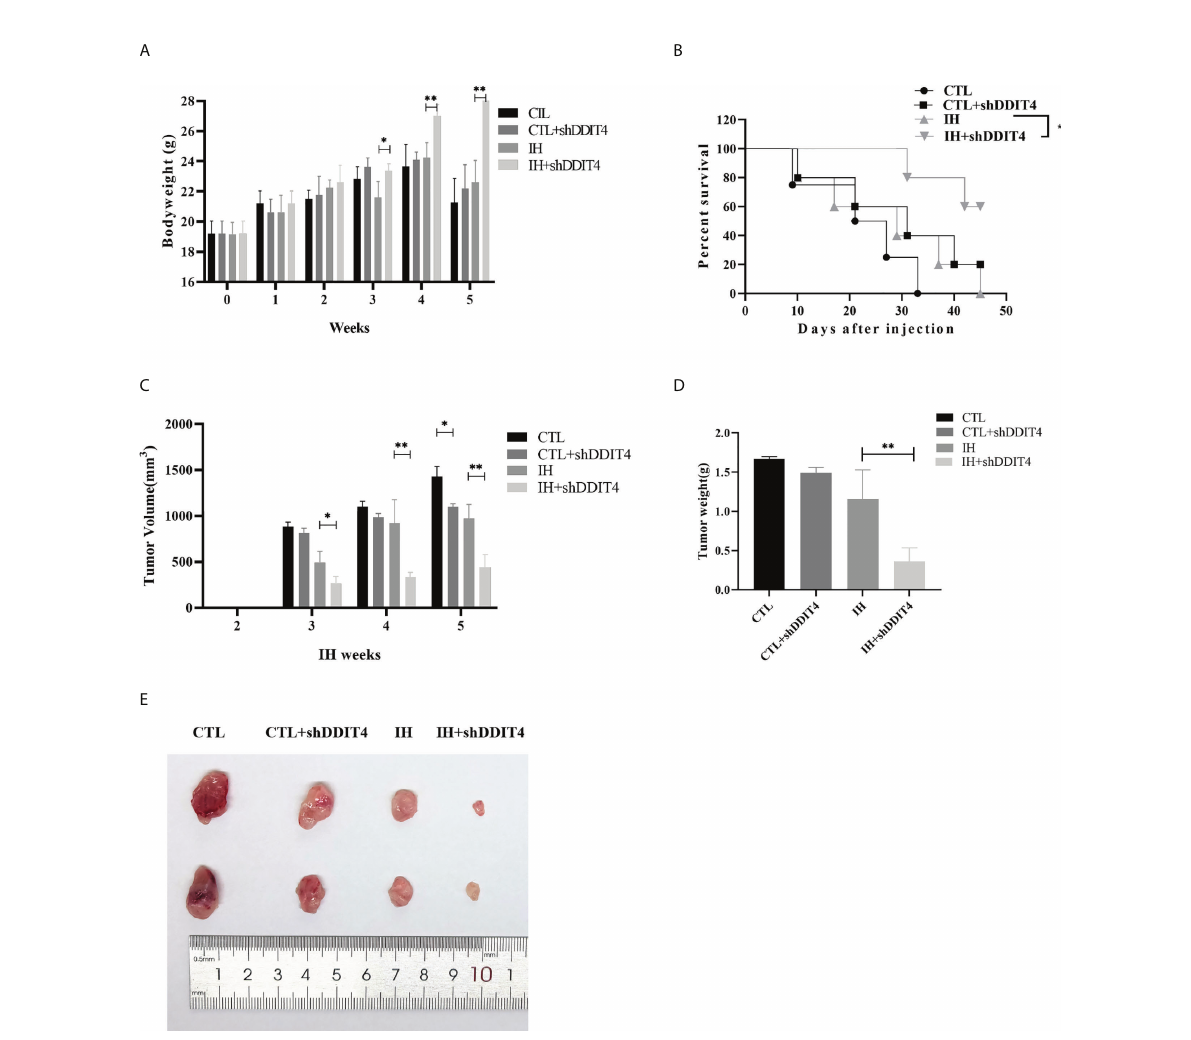
FIGURE 7 DDIT4 restrained tumor formation in vivo under hypoxia. (A) The body weight of mice was measured after intermittent hypoxia (IH) administration in the CTL, CTL+shDDIT4, IH, and IH+shDDIT4 groups at 0~5 weeks. (B) The survival rate in different groups were detected for 5 weeks after injecting NCI-H929 cells into the mice. (C, D) Tumor volume and weight were measured in the 5th week after intermittent hypoxia administration. All experiments were performed triplicate. (E) The representative tumor size was photographed in four groups. CTL, normoxia control; CTL+shDDIT4, normoxia shDDIT4; IH, intermittent hypoxia control; IH+shDDIT4, intermittent hypoxia+shDDIT4. Independent experiments were performed 3 times. n = 5 per group (*, p< 0.05; **, p< 0.01; vs.